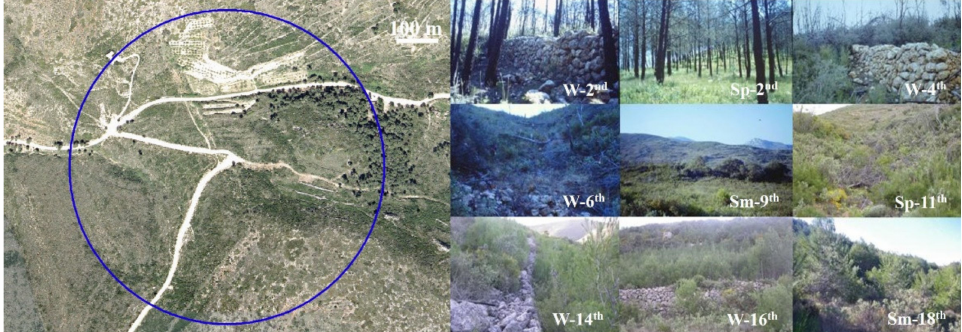
Figure 3. Orthophoto (courtesy of the Valencian Cartographic Institute) of the trapping site of Rebal- sadors (burned area) and some photographs showing its evolution during the post-fire regeneration process (W = Winter; Sp = Spring; Sm = Summer).